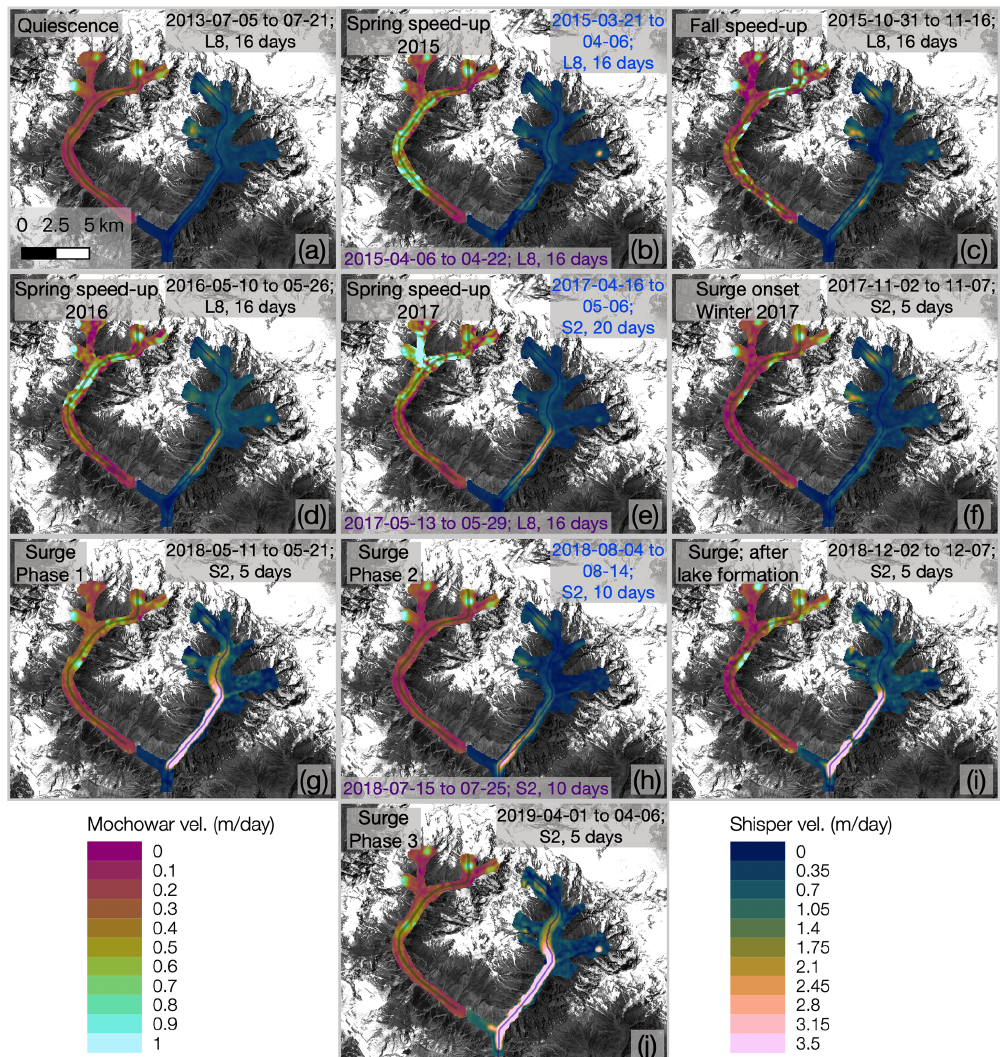
Figure 4. Velocity maps showing the dynamic behavior of Mochowar and Shisper glaciers between 2013 and 2019. (a) Quiescence in the absence of seasonal speed-up; (b) spring speed-up; (c) fall speed-up; (d) enhanced velocities during spring speed-up in 2016; (e) enhanced velocities during spring speed-up in 2017; (f) slow fall onset of the surge; (g) phase 1 of the surge; (h) phase 2 of the surge; (i) phase 2 of the surge after lake formation; (j) phase 3 of the surge. The choice of velocity snapshot is aimed at displaying the most notable velocity patterns of Shisper Glacier, while Mochowar Glacier is used as a reference. Note that the velocity map for each glacier is not always taken over the exact same time period in order to display the cleanest velocity maps, in which case, the time stamp is shown in purple for Mochowar Glacier and blue for Shisper Glacier. The color bars have different scales for either glacier to better display velocity patterns. Perceptually uniform color maps are used in this figure to prevent visual distortion of the data (Crameri, 2018a,